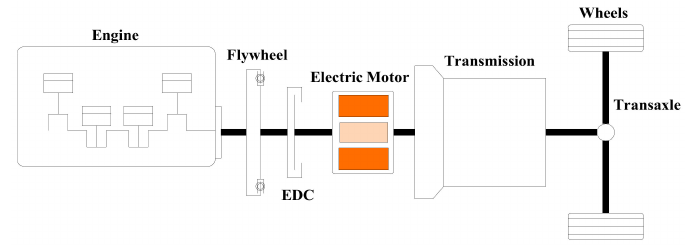
Figure 1. Schematic of P2 HEVs